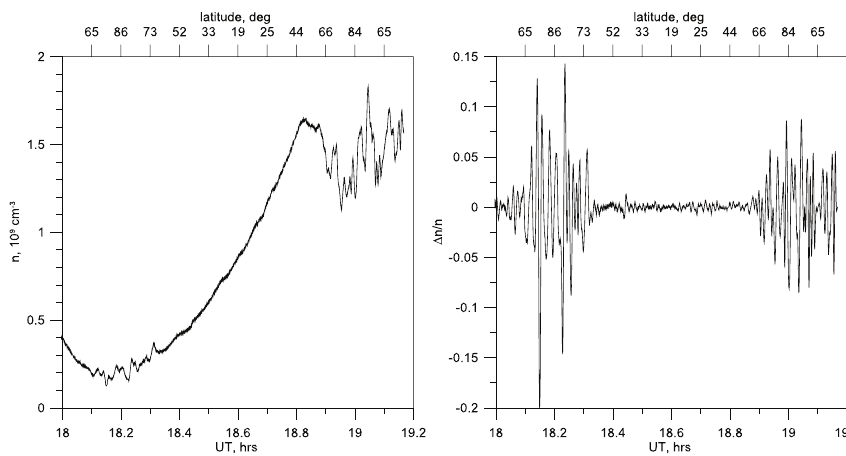
Figure 1. Neutral particle density (left) and relative density variation (right) along DE2 orbit 8257 (29 January